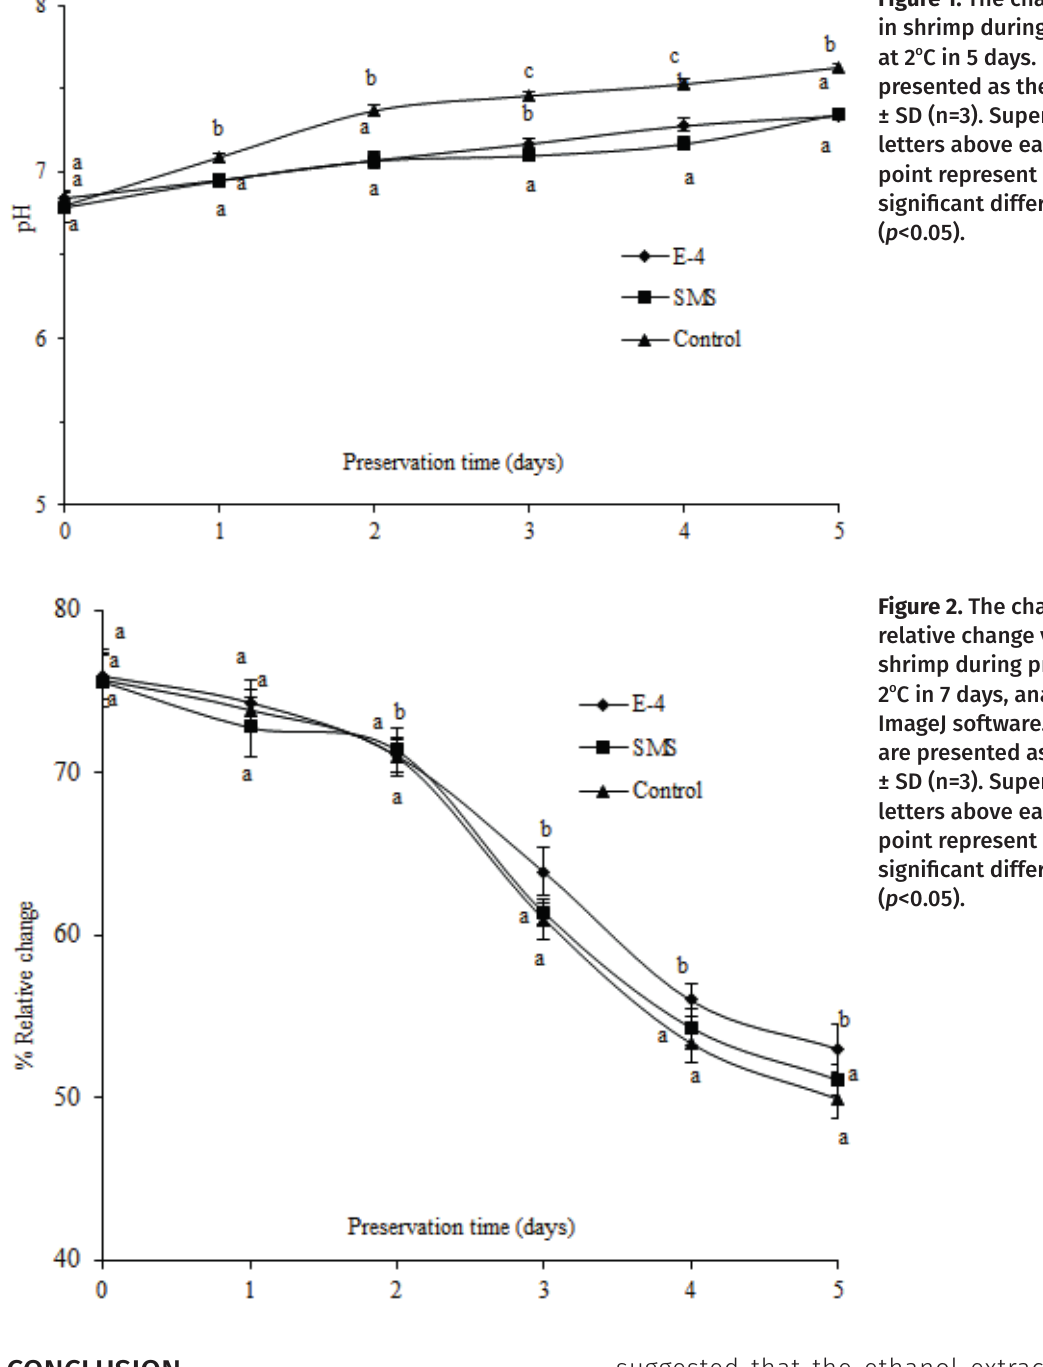
Figure 1. The changes of pH in shrimp during preserving at 2 o C in 5 days. Results presented as the mean ± SD (n=3). Superscript letters above each data point represent statistically signifi cant differences ( p <0.05).